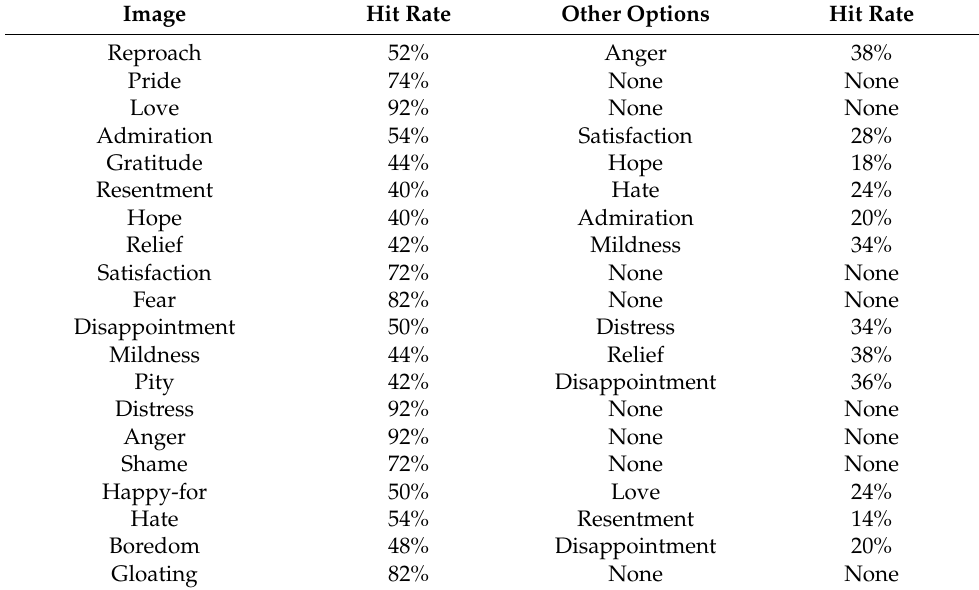
Table 4. Validation experiments for cognitive interpretation of selected emotion words. The “hit rate” is the percentage of correct responses for each image. “Other options” is the most common incorrect